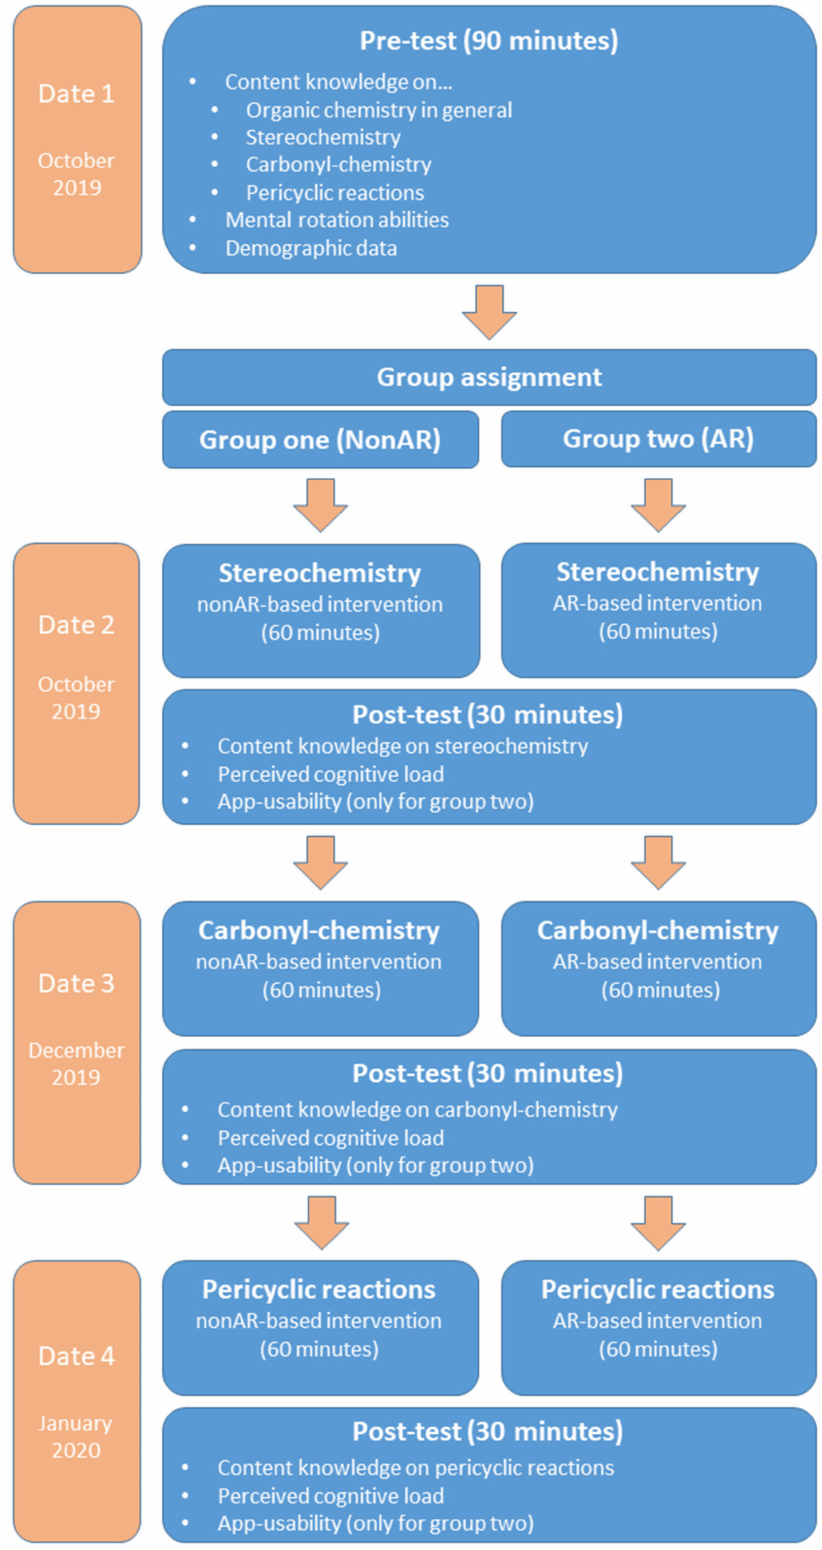
Figure 1. Timetable of the entire study | Used instruments are described in Section